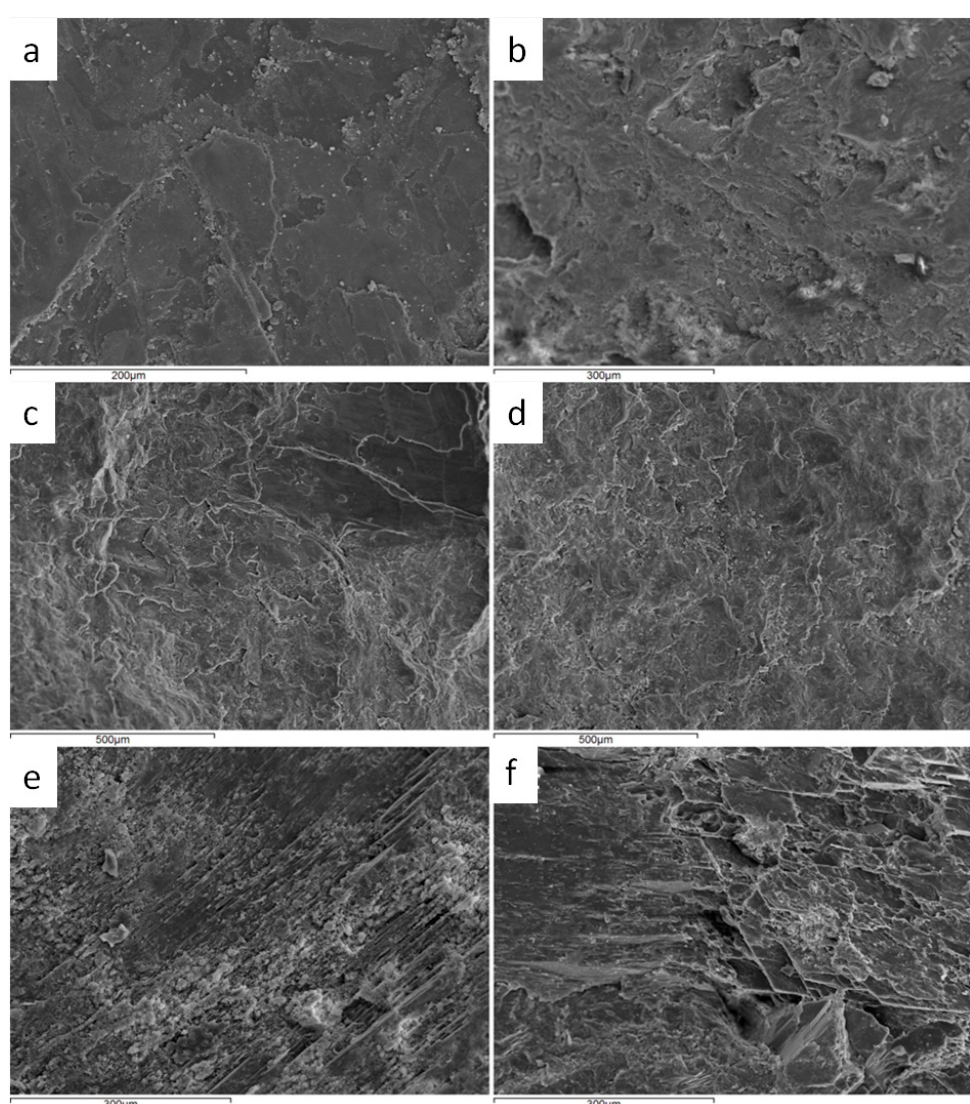
Figure 6. Back scattered images (BSI) showing the surface texture from representative ultramafic rock samples of Veria–Naousa and Gerania ophiolite complexes: ( a ) sample SV5; ( b ) sample SV3; ( c ) sample SG4; ( d ) sample SG8; ( e ) sample SV1; ( f ) sample